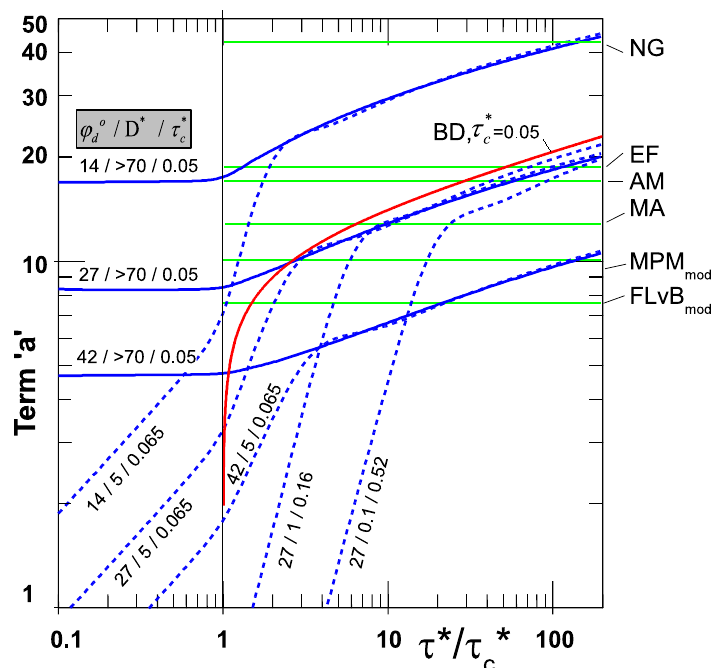
Figure 6. Terms ‘a’ of the di ff erent bed-load formulae. Full lines indicate hydraulically rough flow conditions, dashed lines stand for not hydraulically rough flow. Blue lines result from Equations (31) and (38) in combination with Equation (33). Red curve: Equation